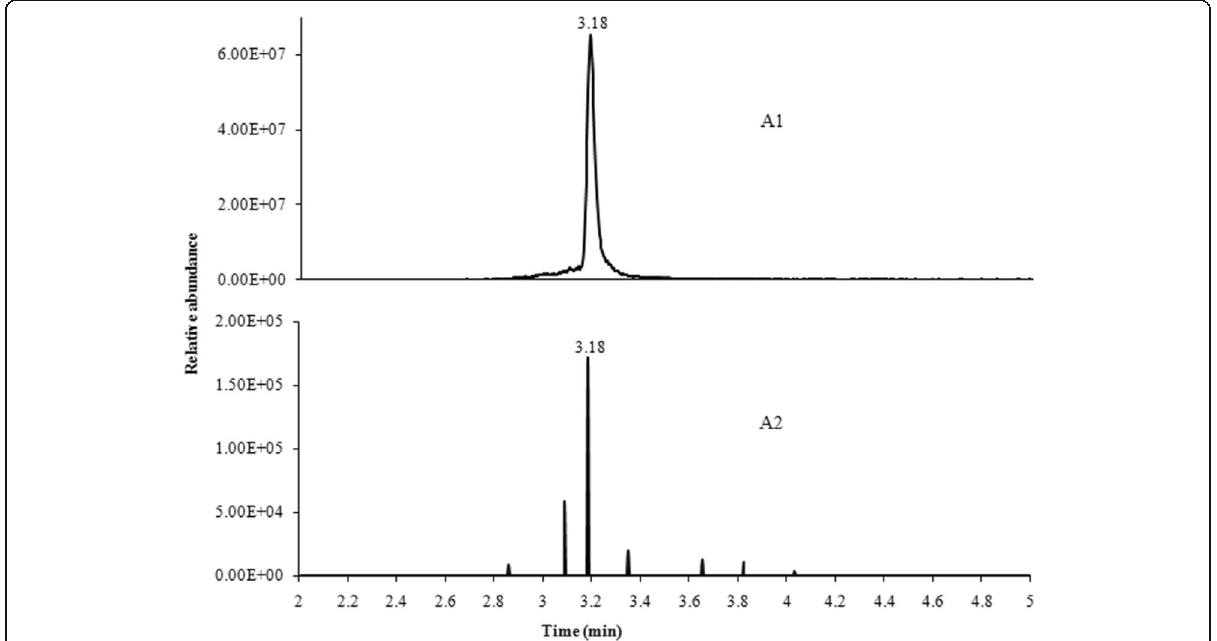
Fig. 4 Example of typical chromatography and spectra from a full MS/dd-MS 2 experiment: (A1) extracted ion chromatogram of enrofloxacin [M + H] + m/z 360.17081 in sample N0. 17; (A2) dd-MS 2 total ion chromatogram of enrofloxacin of [M + H] + m/z 245.10895 in sample No.